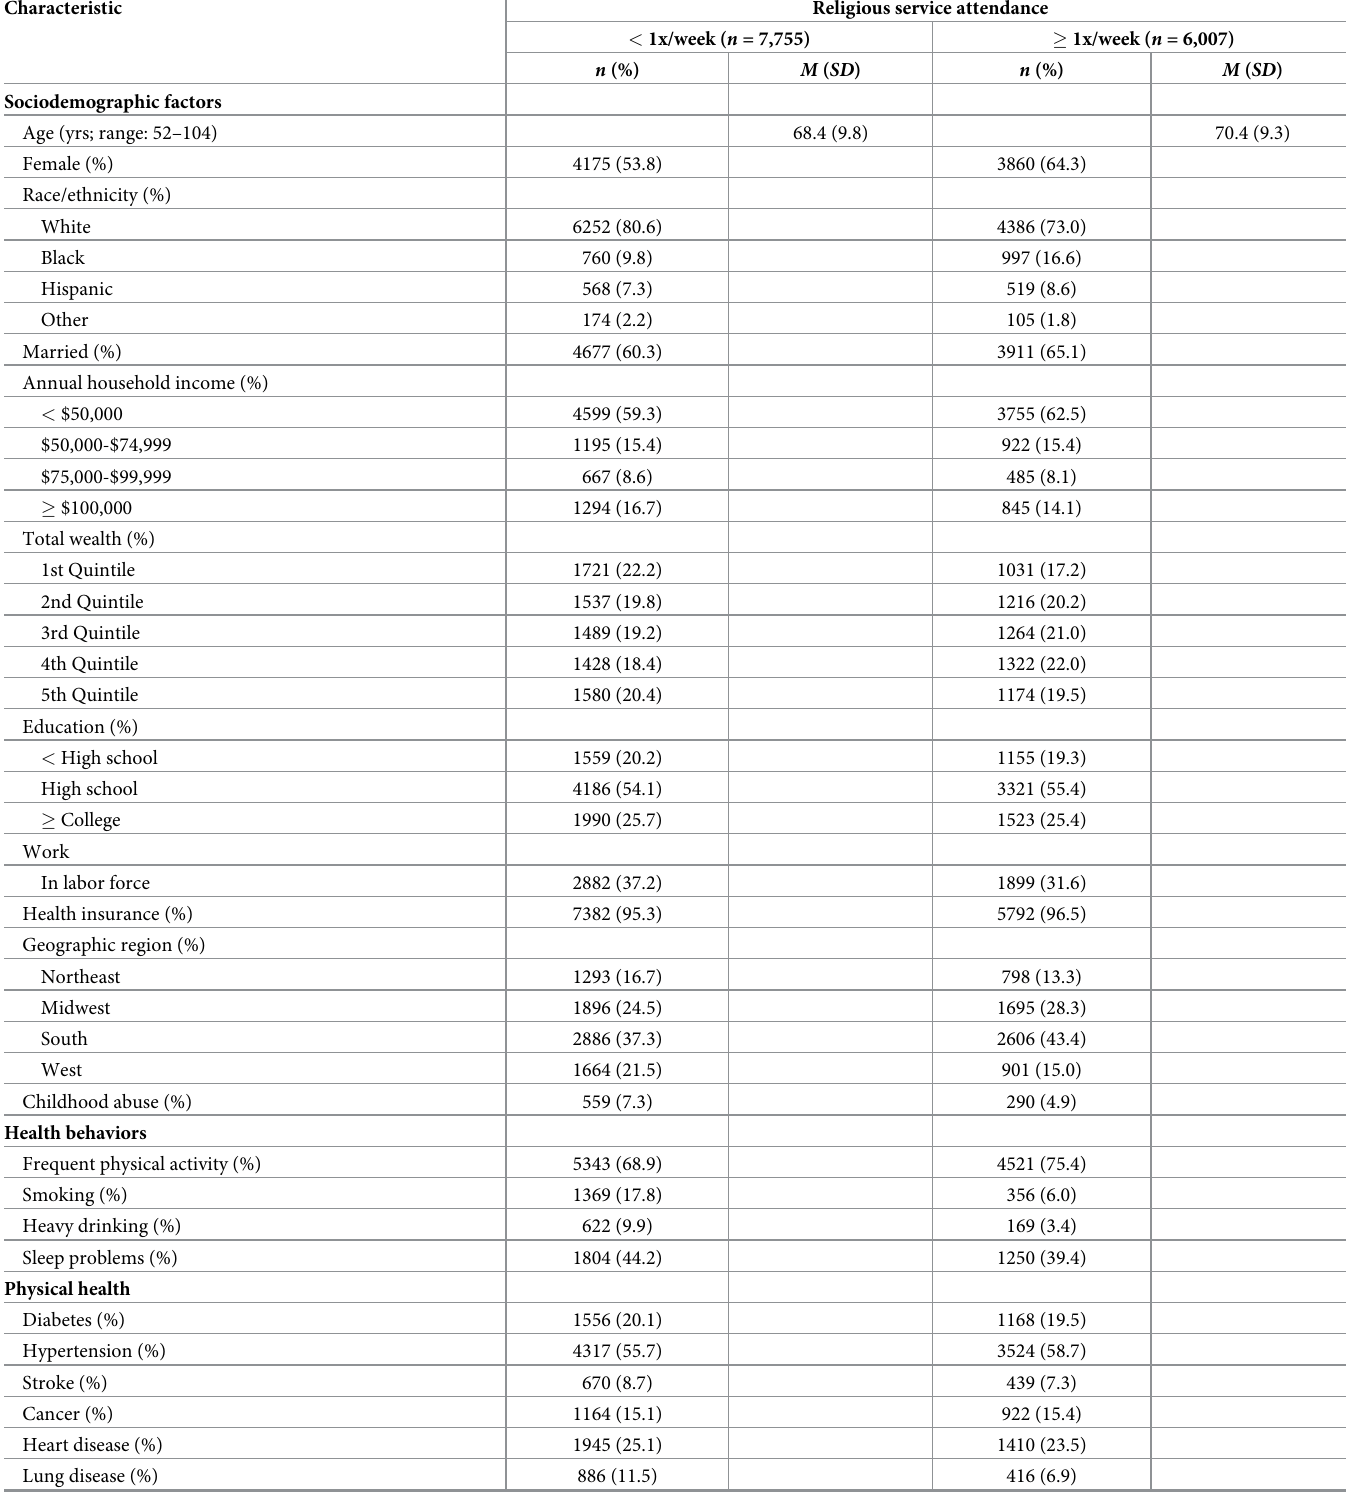
Table 1. Distribution of participant characteristics (T 0 ) by religious service attendance (T 0 ) a,b,c